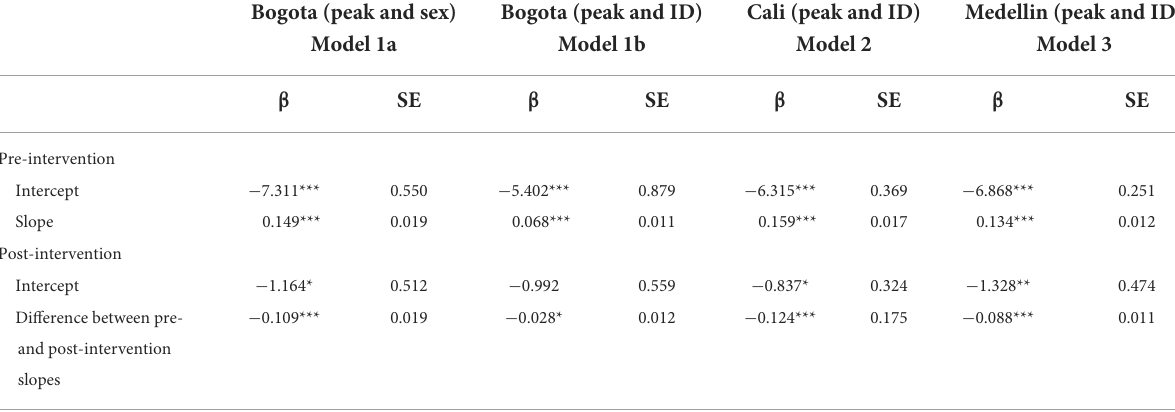
TABLE 2 Single ITSA predicting the effect of peak and sex/peak and id on the COVID-19 infection rate, by city; the interruption time-point of the analysis is 14 days after the actual implementation of the policy. Bogota (peak and sex) Bogota (peak and ID) Cali (peak and ID) Medellin (peak and